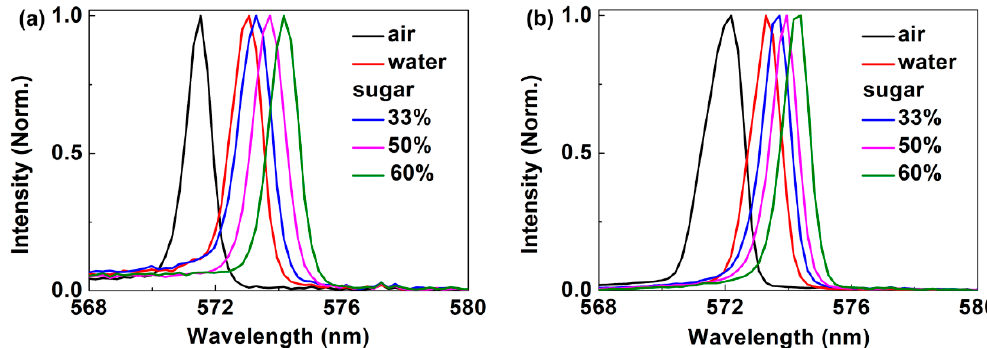
Figure 4. Measured spectra of the DFB polymer laser with different ambient refractive indices. ( a ) The SGA cavity. ( b ) The SAG cavity.